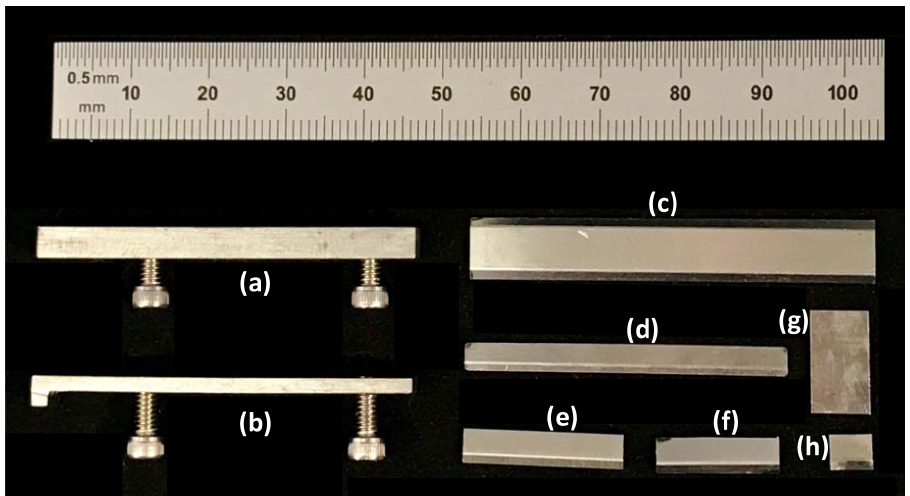
FIG. 19. Photograph of the types of magnetic shims used in tuning the HGVPU. (a) and (b) are side shims, placed on the sides of the pole for strong trajectory adjustments. Magnetic forces hold them in place; the screws are used to adjust their distance from the side of the pole. (c) is a phase shim, placed to cover the entire gap side of the magnet (the tip of the magnet is recessed from the pole tips by 0.5 mm so there is space for a 0.1- or 0.2-mm-thick shim). The bent edges shape the shim to conform to the magnet chamfers. (g) is a flat shim, placed to span from the center in z of one magnet to the center in z of the next magnet, immediately adjacent to the outside edge of the pole so the minimum gap is unaffected. It is a weaker version of the side shim. (d), (e), (f), and (h) are trajectory shims of various lengths in y that cover only half of the z-distance of the magnet face, with the bend to conform to the magnet chamfer. They may or may not be centered on the magnet in y depending on the correction needed. Different lengths and placements allow for different trajectory and multipole corrections, as do asymmetric (only one side) placements of the side and flat